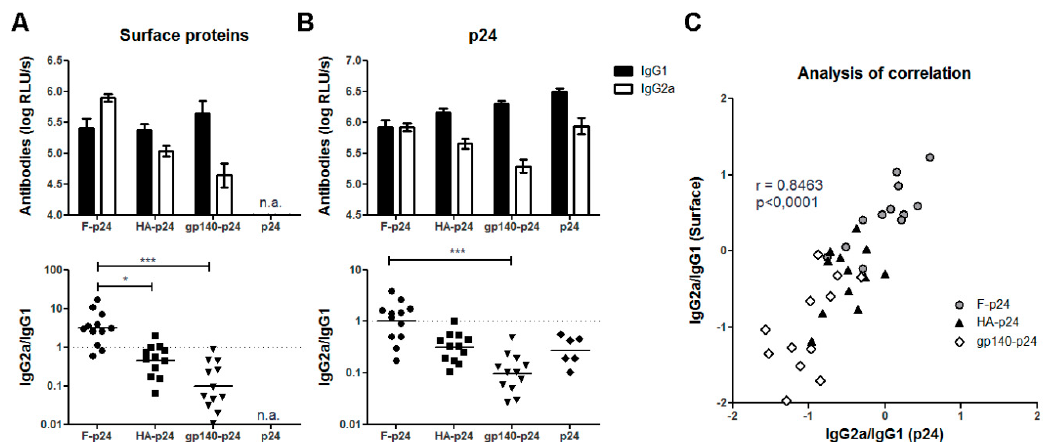
Figure 3. Antibody responses induced by DNA vaccines encoding p24 fusion proteins. Balb/c mice were immunized twice with the plasmids F-p24, HA-p24, gp140-p24, and p24, encoding fusions proteins as depicted in Figure 1. Two weeks after the booster immunization, the antibody levels specific for the respective surface proteins ( A ) or for the p24 antigen common to all fusion proteins ( B ) were determined by antigen-specific ELISAs (serum dilution 1/10,000). The RLUs for both IgG1 and IgG2a are depicted as mean values with SEM for the vaccine groups (top) and the ratio of RLUs for IgG2a to IgG1 were calculated for each mouse individually (bottom). The bars show the geometrical mean values ( n = 6; * p < 0.05, ** p < 0.01, *** p < 0.001, Kruskal-Wallis-test with Dunn’s post-test). ( C ) Linear regression analysis (Pearson) between the IgG2a/IgG1-ratios to the surface protein and the fused p24.